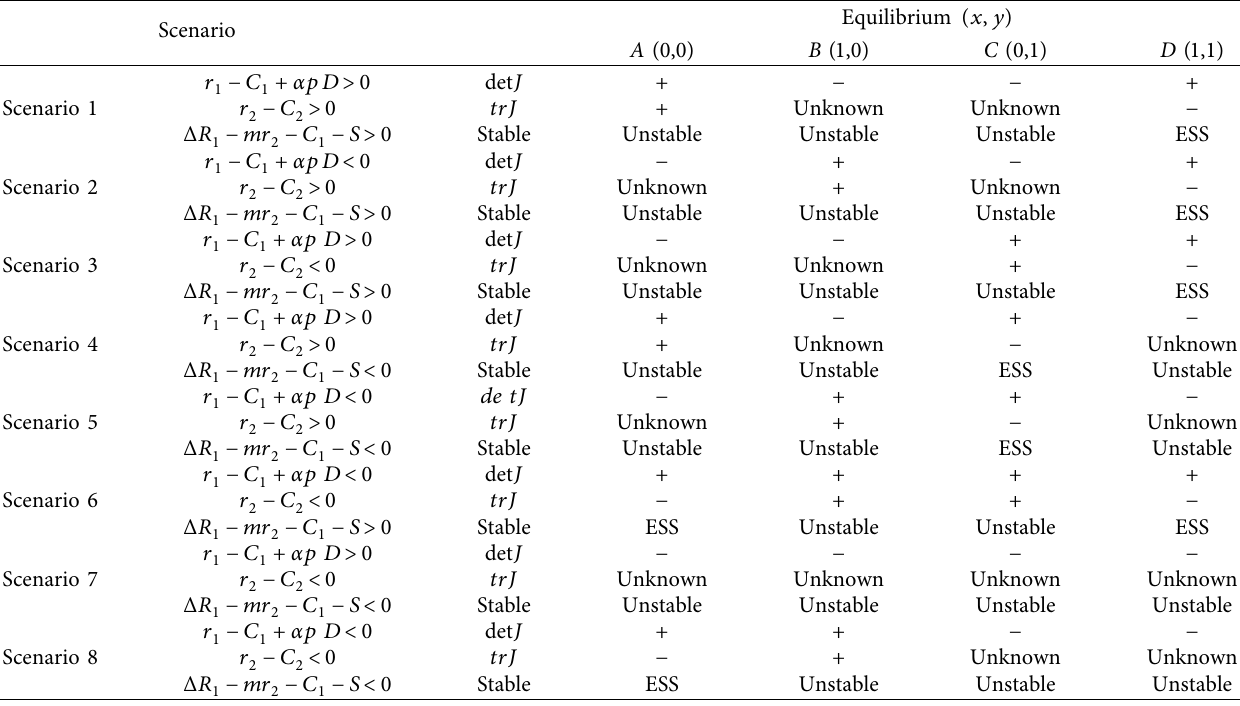
Table 4: The evolutionary stabilization strategy of the